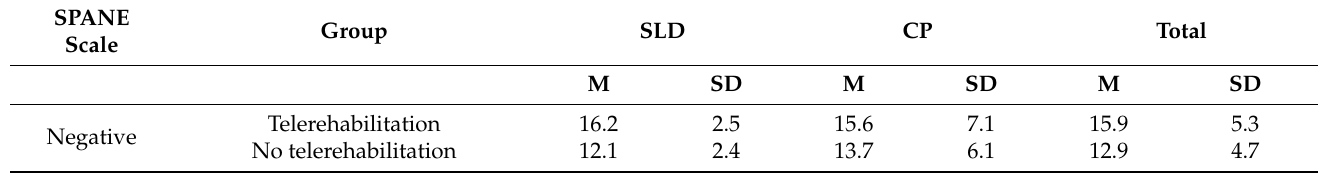
Table 3. SPANE’s mean scores and SD of the three groups by